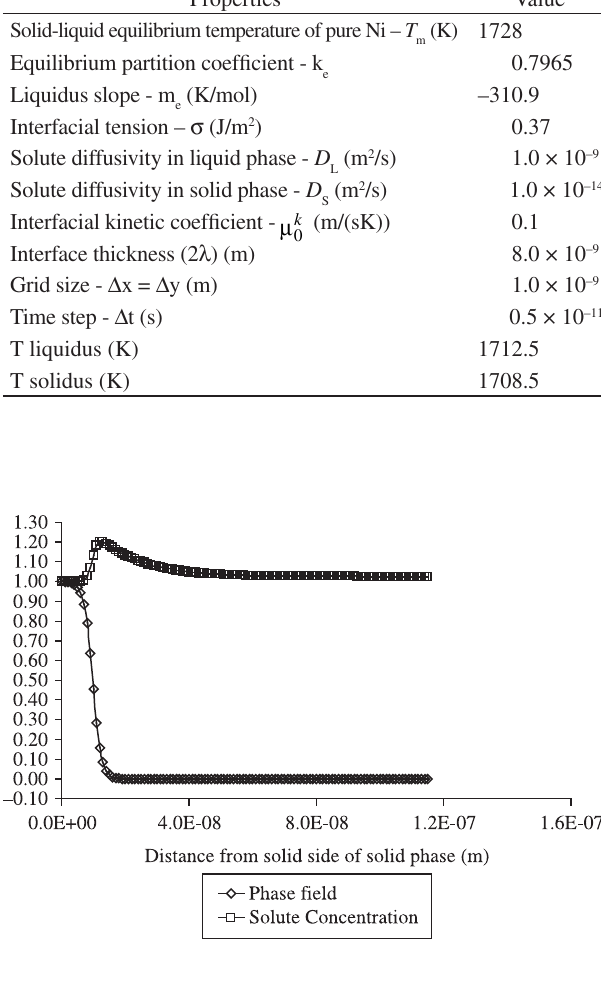
Table 1. Properties and parameters of Ni-0.05 mole fraction of Cu dilute alloy 6